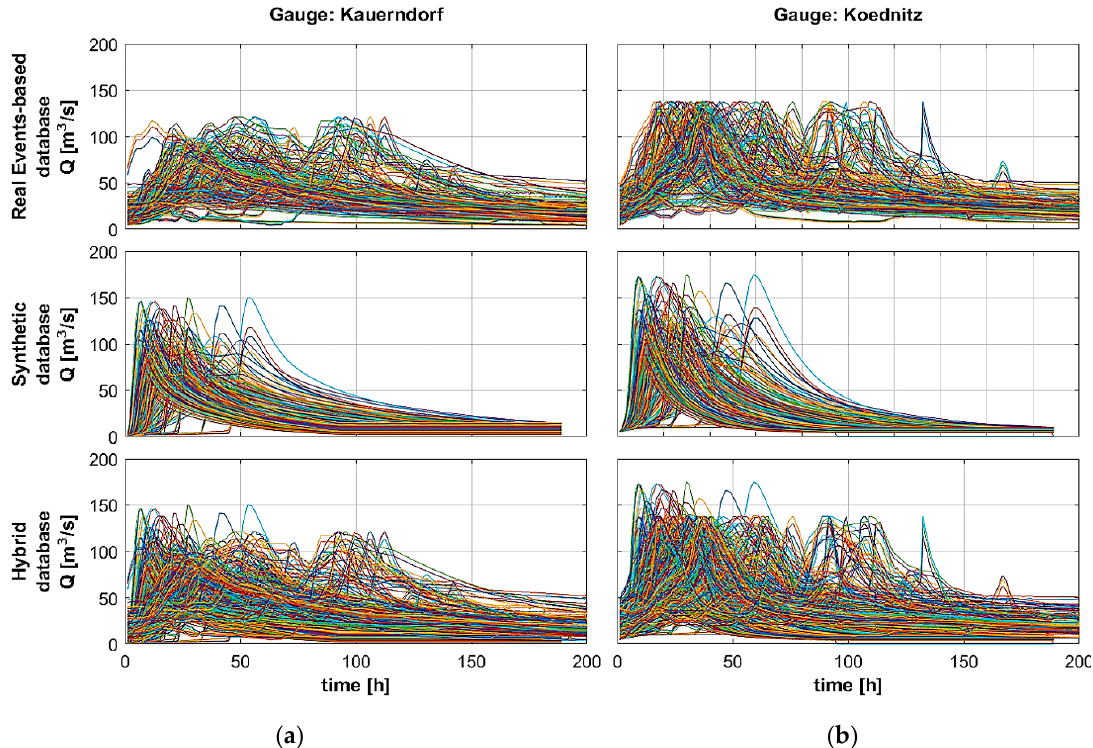
Figure 6. All the discharge events in the REBD, SD, and HD databases for the gauges of Kauerndorf ( a ) and Ködntiz ( b ).